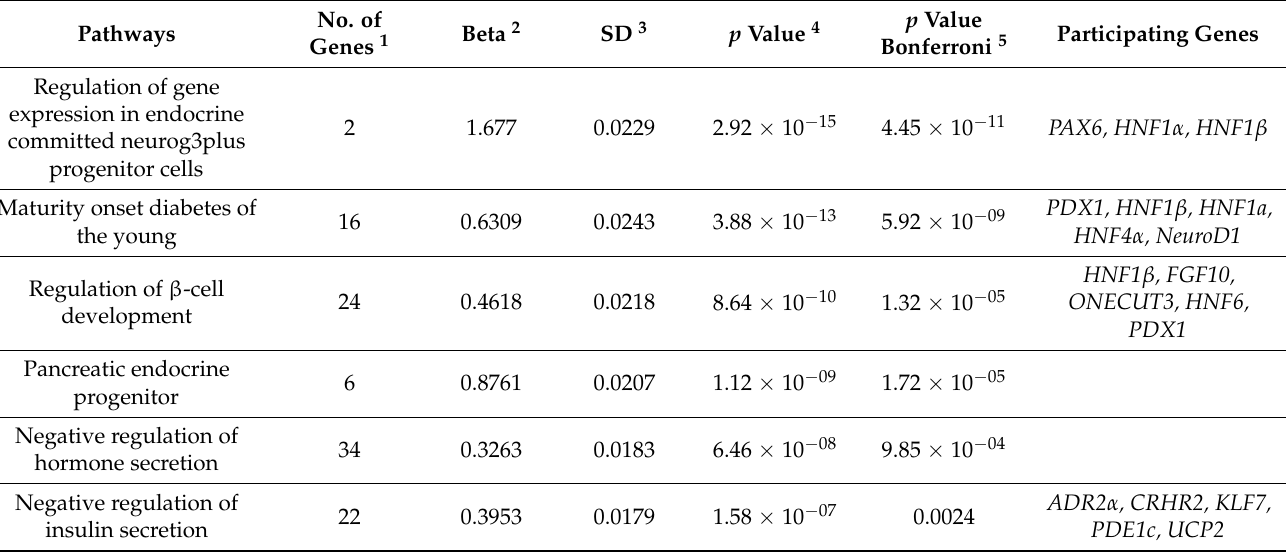
Table 5. Pathways related to genetic variants for type 2 diabetes.